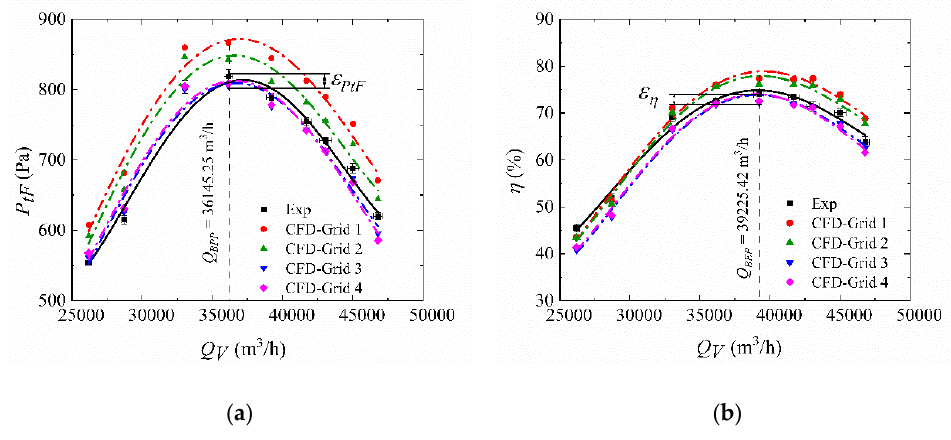
Figure 6. Variation in experimental and calculated performance curves: ( a ) performance curve of total pressure; ( b ) performance curve of total efficiency